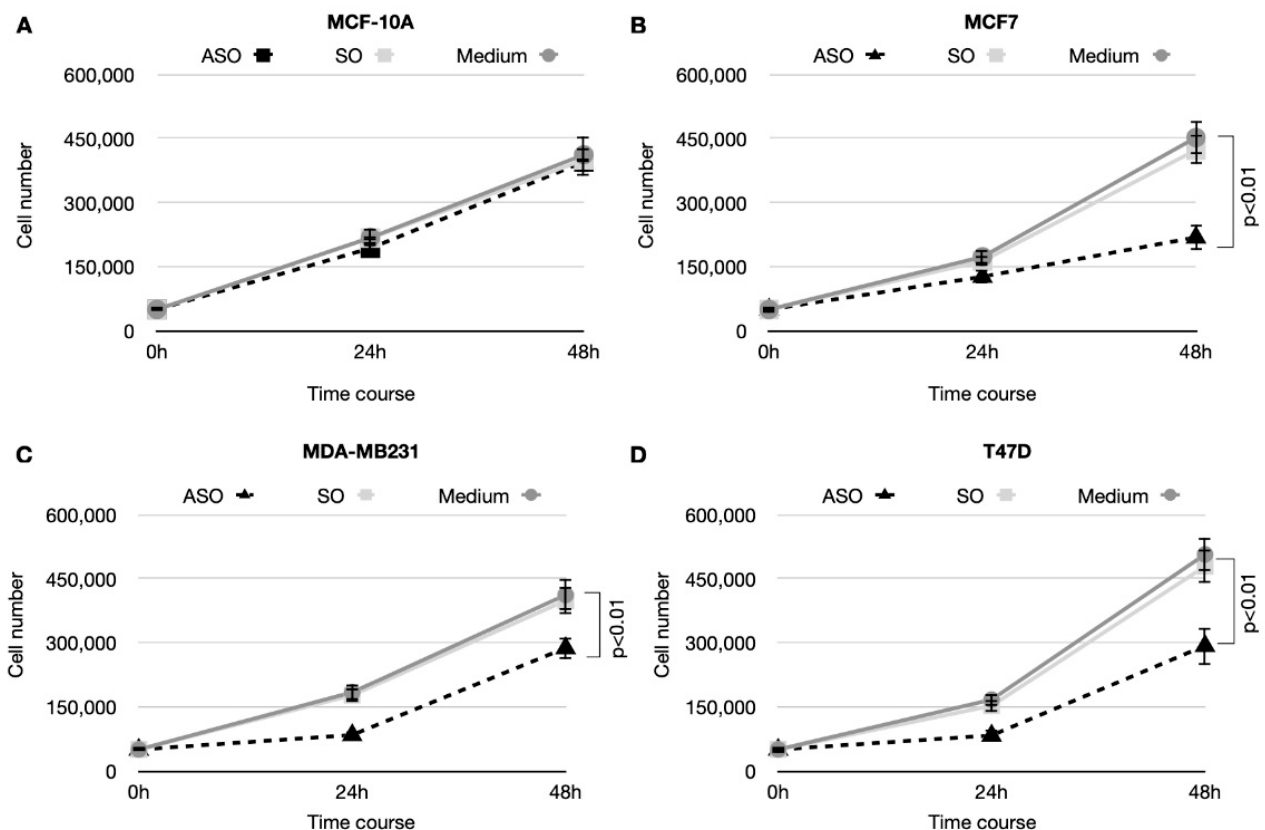
Figure 3. Graphs showing cell proliferation assay in ( A ) non-tumorigenic cells (MCF-10A) and in ( B – D ) breast cancer cell lines (MCF7, MDA-MB231, and T47D). Cells were counted at the time of seeding and after 24 and 48 h after transfection. Data are presented as means ± SD of three independent experiments, calculated with χ 2 test.